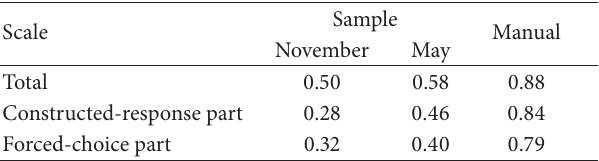
Table 7: Internal consistency of the HCTA with scales as variable.